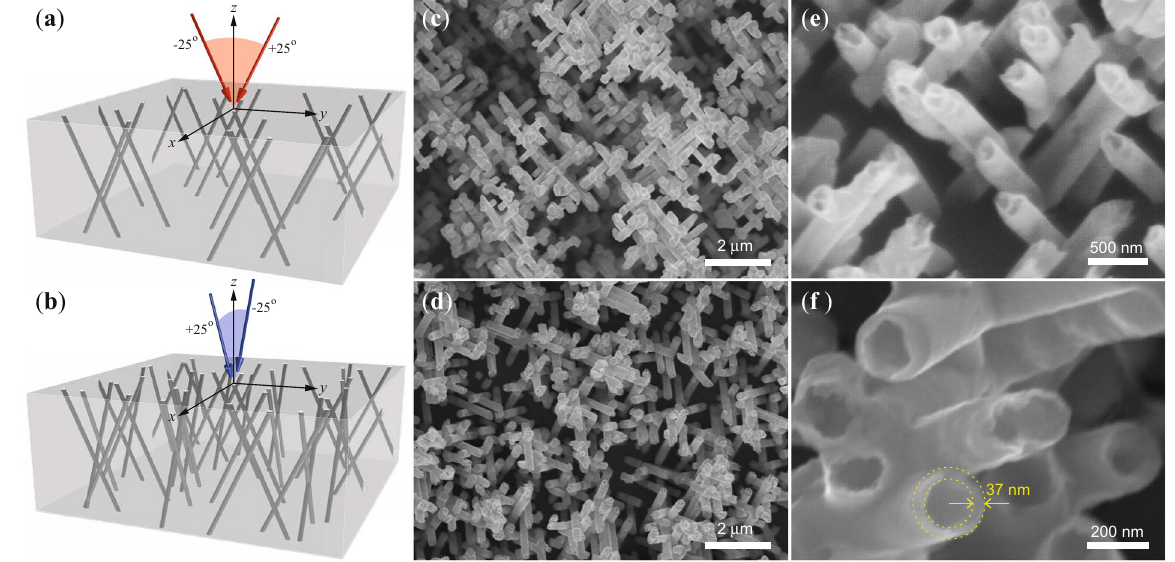
Figure 1. ( a ) Schematics of the first step of the sequential track etching irradiation process, which consists in a first irradiation exposure of the PC film at the two fixed incidence angles of − 25° and + 25° relative to the OOP direction. ( b ) For the second irradiation step the PC film is rotated in the x - y plane by 90° and re-exposed to the irradiation flux at the same fixed angles with respect to the OOP direction. SEM images of electrodeposited at a deposition potential of − 1 V of ( c ) a Ni CNW network and ( d ) a Ni CNT network obtained after the complete dissolution of the PC nanoporous host template. Close magnification views of the CNT network, showing ( e ) the tubular structure and crossing zones of the nanotubes and ( f ) sharp details of the nanotubes where an average wall thickness of 37 nm has been obtained. The dotted lines are guides for the